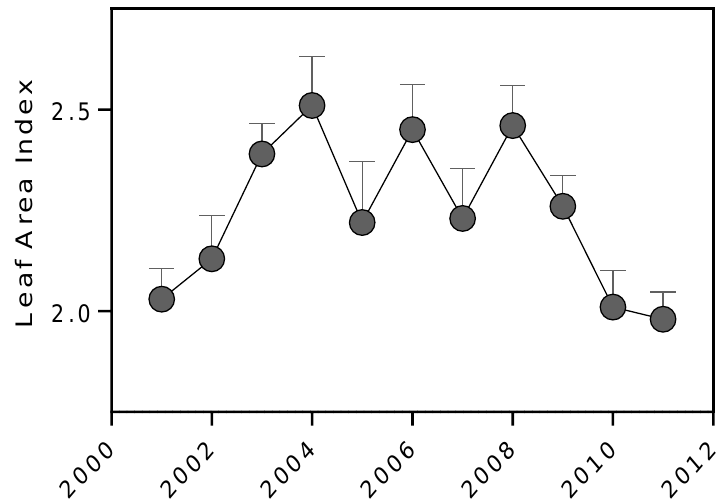
Fig. A2. Time course of the peak LAI derived from continuous measurements of half-hourly 839 f between 11 AM and 1 PM from DOY 205 to 225. The Stem Area Index SAI was 840 APAR estimated by image processing of hemispheric photography and assumed constant for the 841 diameter. Figure A1. Relationship between aboveground perennial biomass (g Dry Matter) and the corresponding belowground biomass (g Dry Mat- whole period and equal to 0.5. The relationship between leaf area index and water stress 842 ter). The belowground biomass is the sum of biomass values for root crown, roots greater than 5cm and roots ranging from 1 to 5cm in diameter. integral (WSI) is statistically non-significant. 843